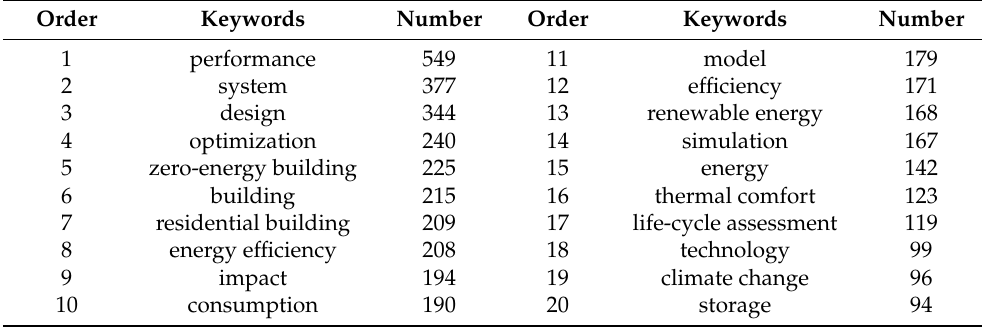
Table 3. Top 20 high-frequency keywords in zero-energy building research.